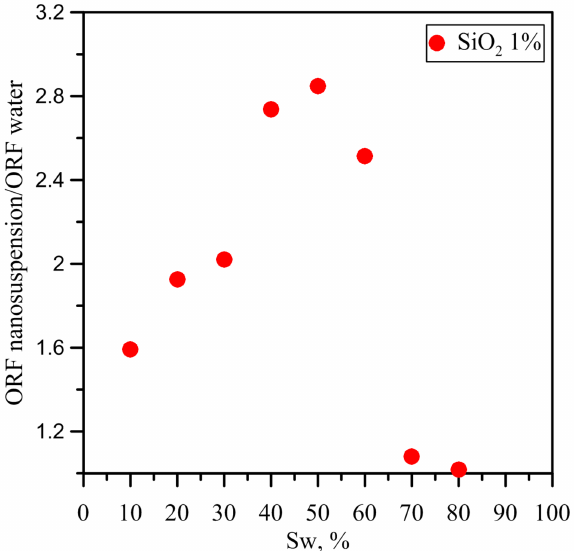
Figure 8. Dependence of relative ORF on water saturation for different particle